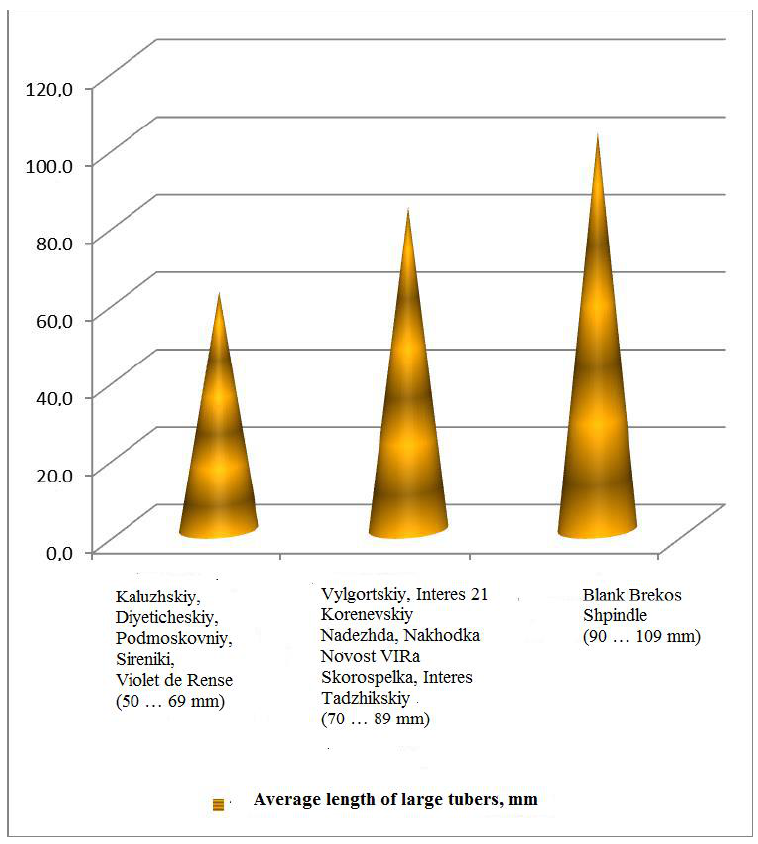
Figure 4. Average length of large tubers, mm (1st ten-day period of September).